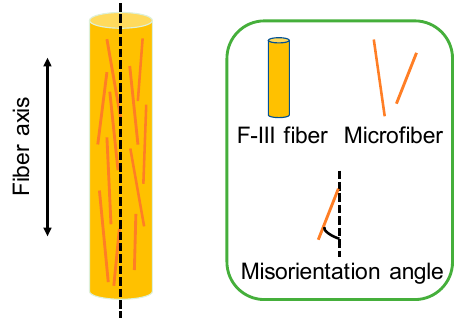
Figure 4. Schematic diagram of microfiber and misorientation angle in F-III fibers.